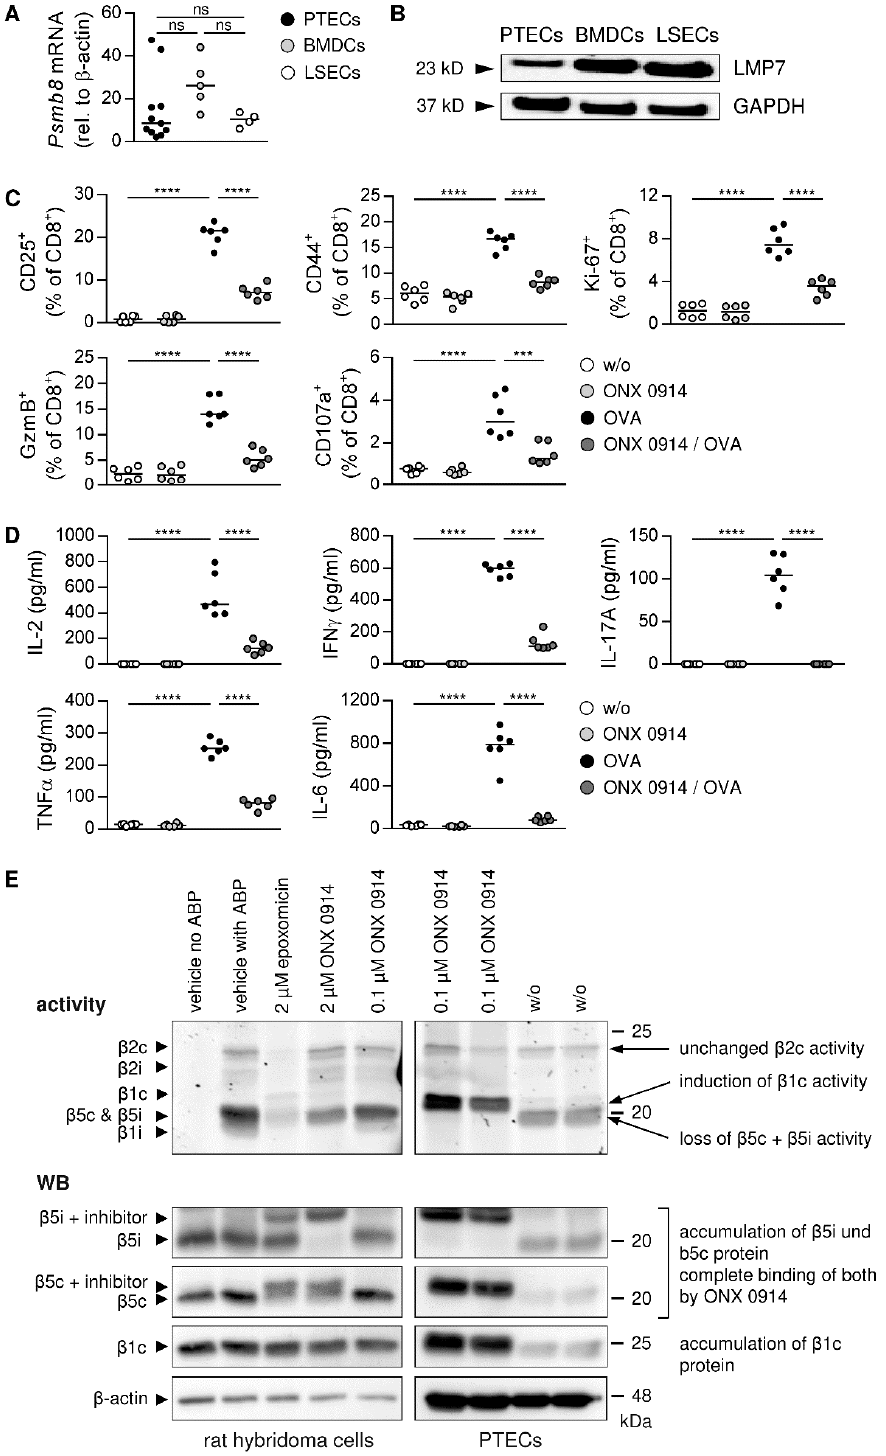
Figure 6. Proteasome-dependent CD8 + T-cell activation. ( A ) Expression of Psmb8 was analyzed in PTECs, BMDCs, and LSECs by quantitative RT-PCR and normalized to the reference gene β -actin. Medians of at least four experiments are shown. ( B ) LMP7 protein expression was determined by